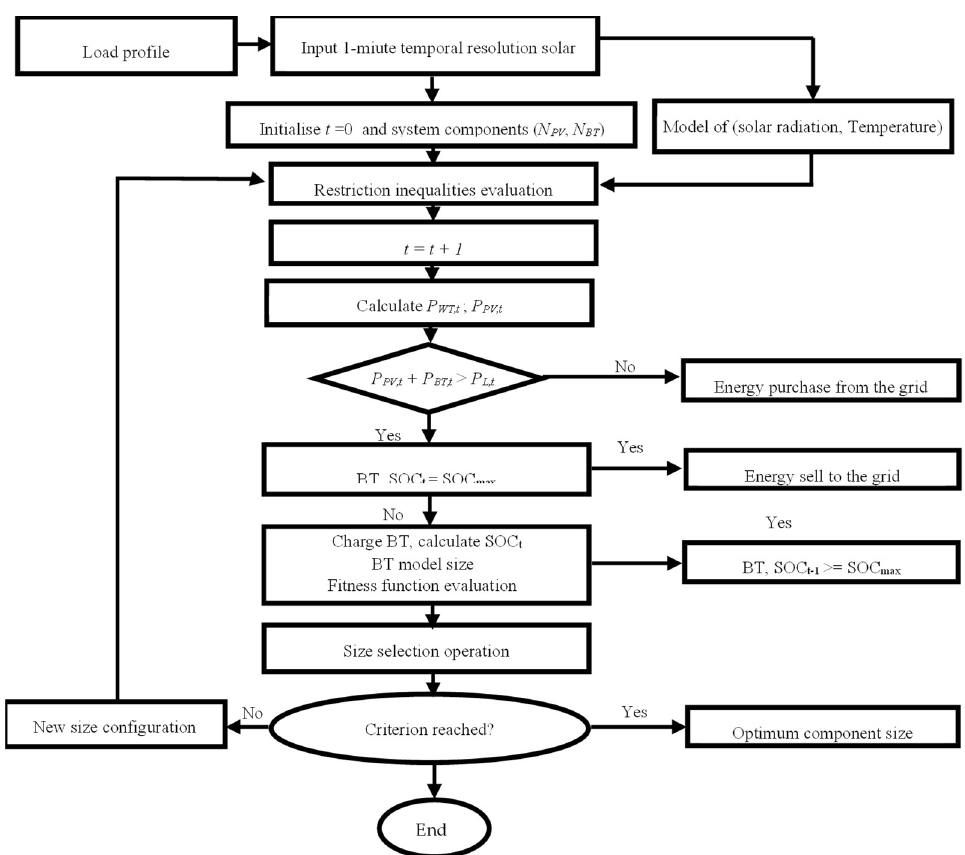
Figure 6. The flow chart for simulating an energy system.